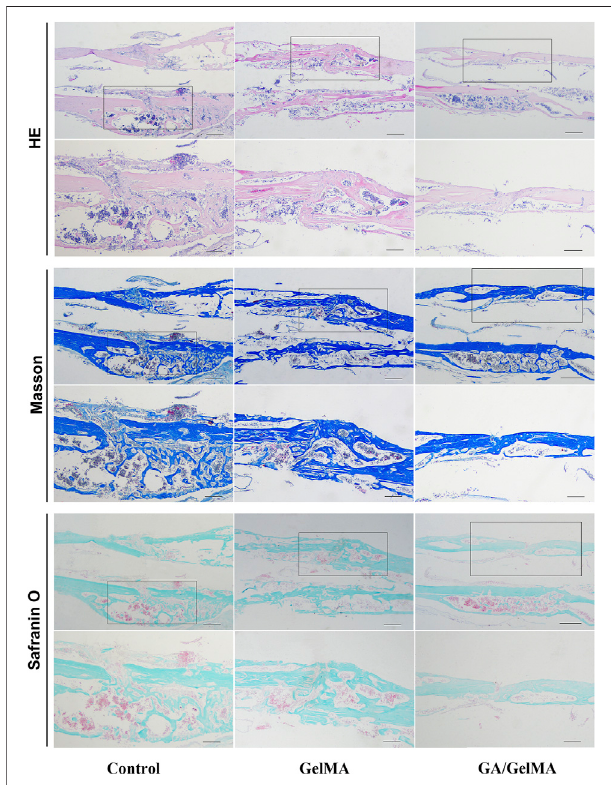
FIGURE 7 | Histological evaluation, including HE, Masson ’ s trichrome, Safranin O and fast green staining of mouse femoral fracture area at 1 month after surgery. Scale bar, 500 μ m.